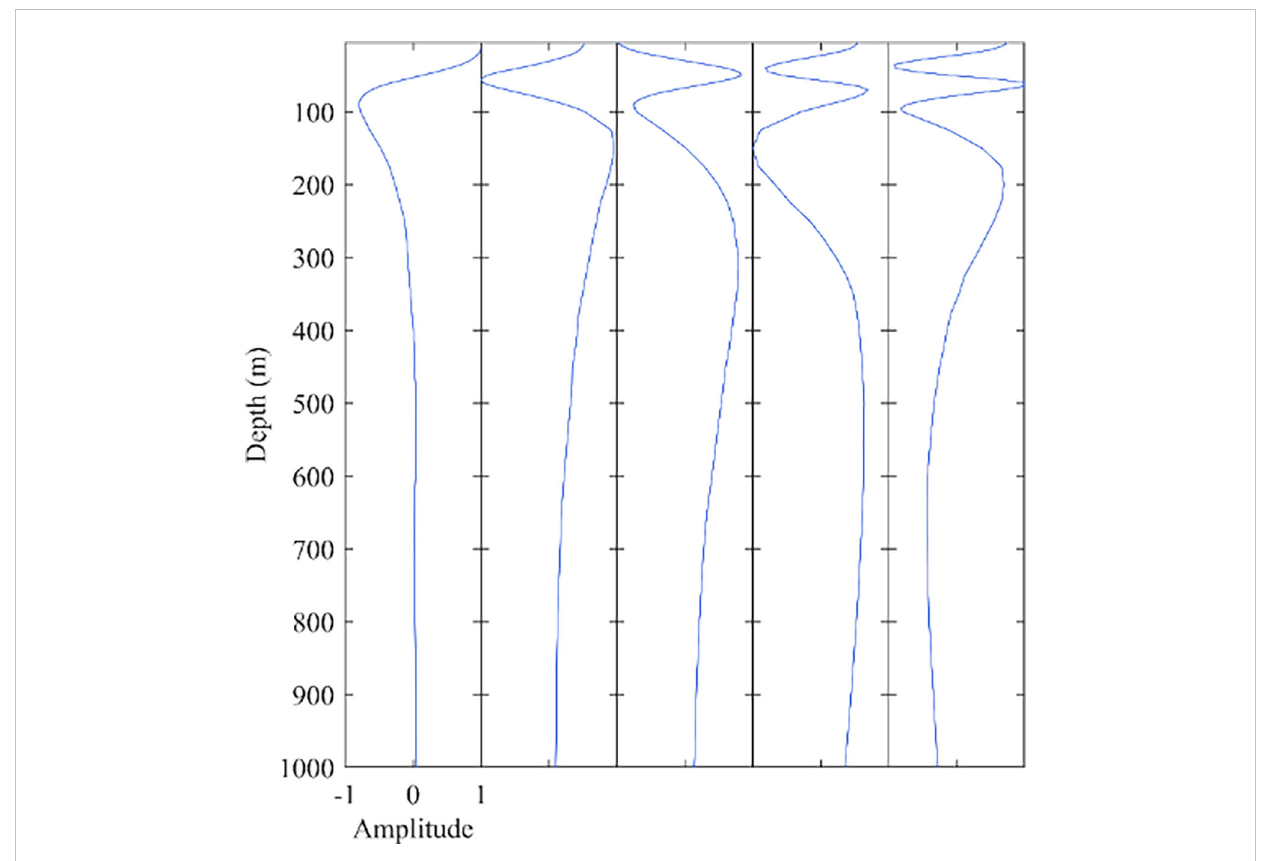
FIGURE 2 First fi ve orders of the empirical orthogonal